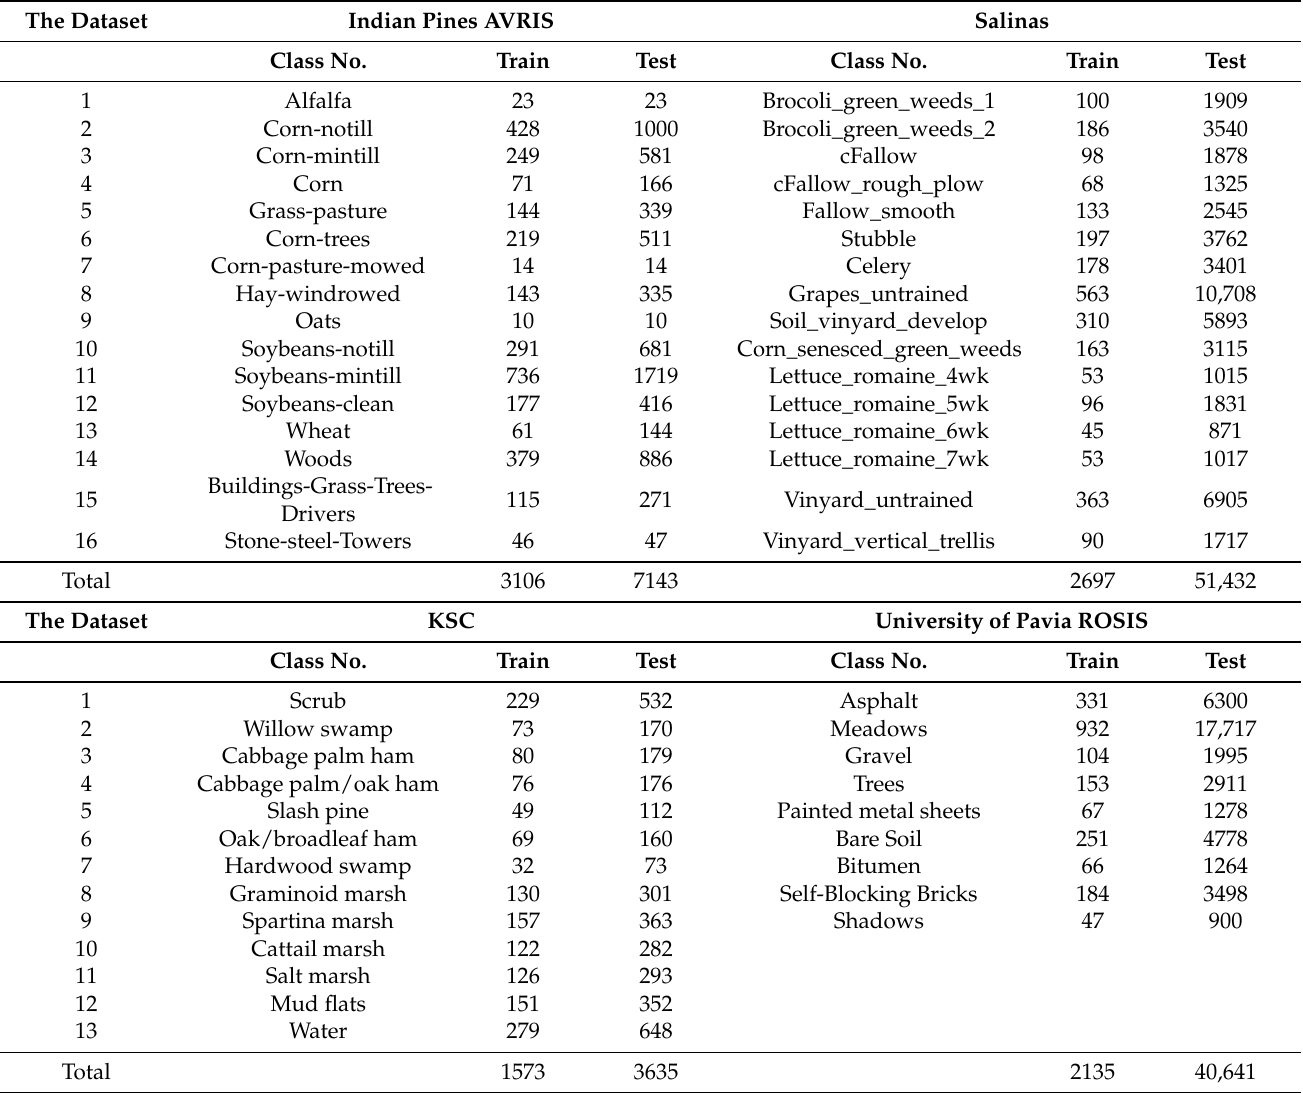
Table 1. Data information of Indian Pines AVRIS, Salinas, KSC and University of Pavia ROSIS. The